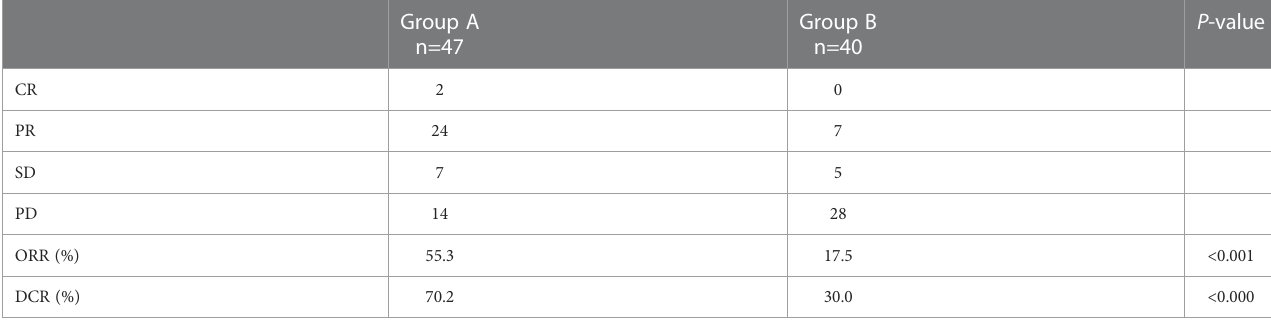
TABLE 2 Response of intrahepatic HCC.